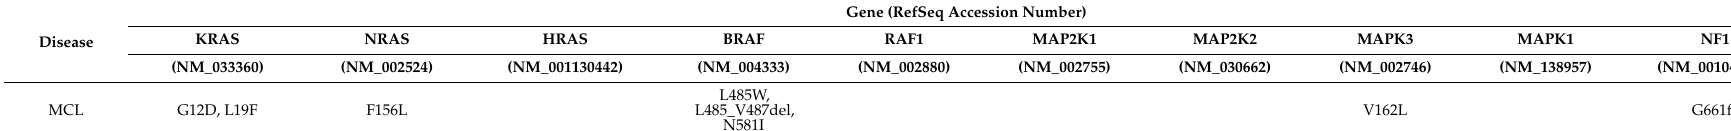
Table 1. RAS-MAPK pathway aberrations in mature B cell lymphoproliferative